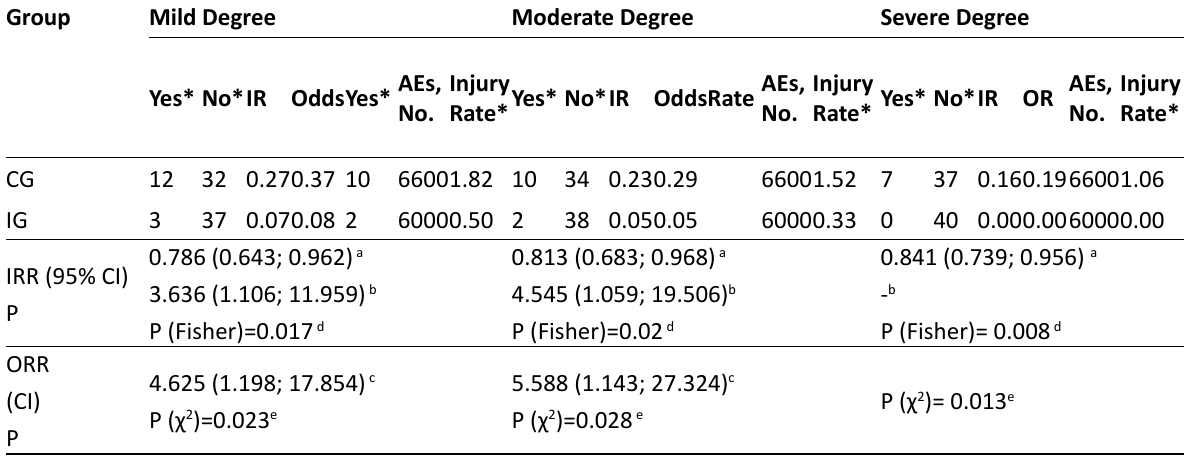
Table 4. Indicators of risk of injuries and diseases of the elbow in the Control (n = 44) and Intervention Groups (n = 40) groups during the